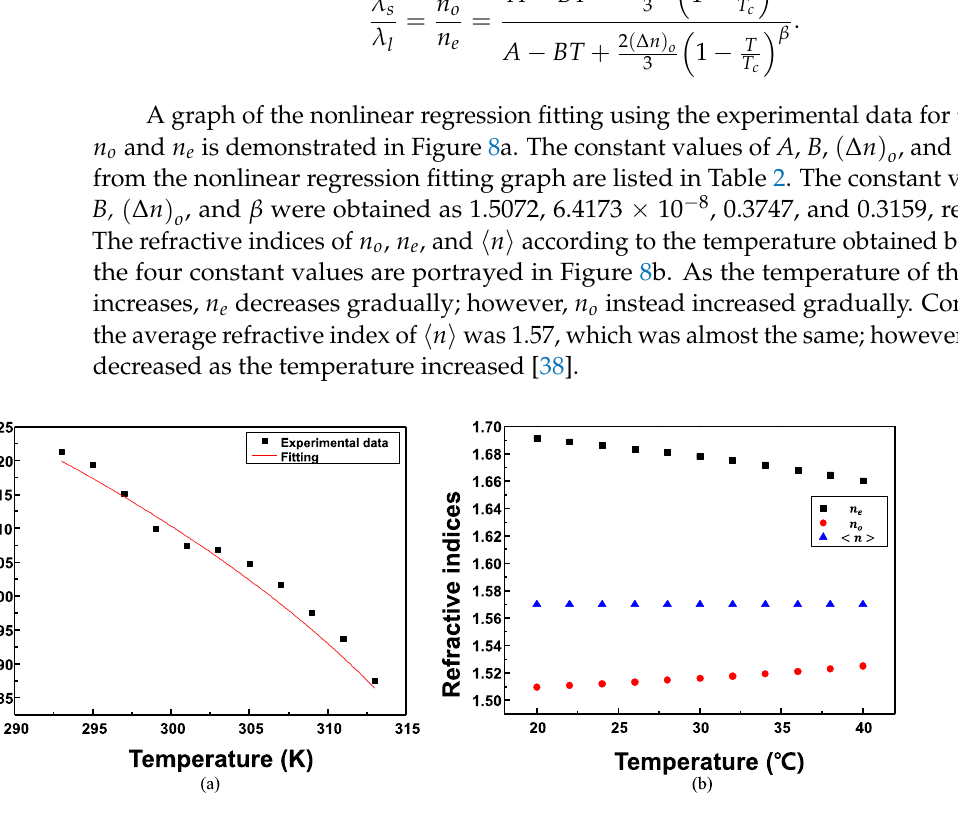
and (cid:5) and (cid:8) (cid:6) ,